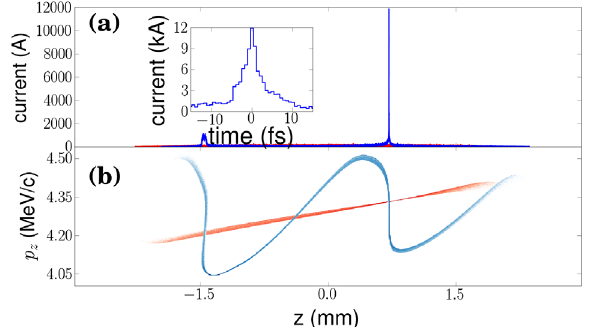
FIG. 11. Current profiles (a) and longitudinal phase spaces (LPS) (b) at the entrance of the DLW structure (red traces) and at location of maximum compression (blue traces). The simulation corresponds to the case λ ¼ 2 . 06 mm in Fig. 10. The inset in plot (a) corresponds to a zoom of plot (a) around the ∼ 12 kA peak with its origin of the temporal axis corresponding to z ¼ 0 . 693 mm in plot (a) axial coordinate. Maximum bunching, in this scenario, occurs 43.9 cm downstream of the